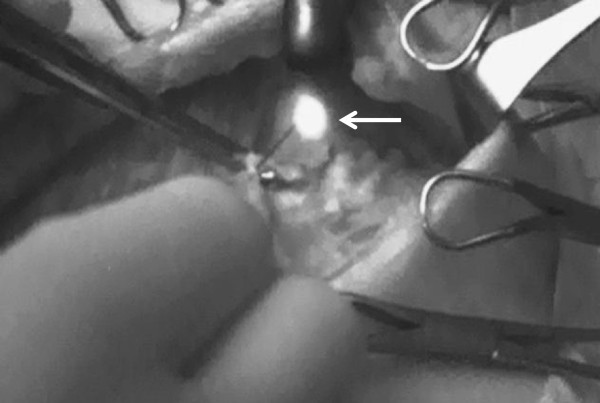
The picture of performing intraoperative FNAC for ARM node. This picture shows performing intraoperative FNAC for an ARM node (indicated with a white arrow) with a 23-gauge needle in the surgical field.